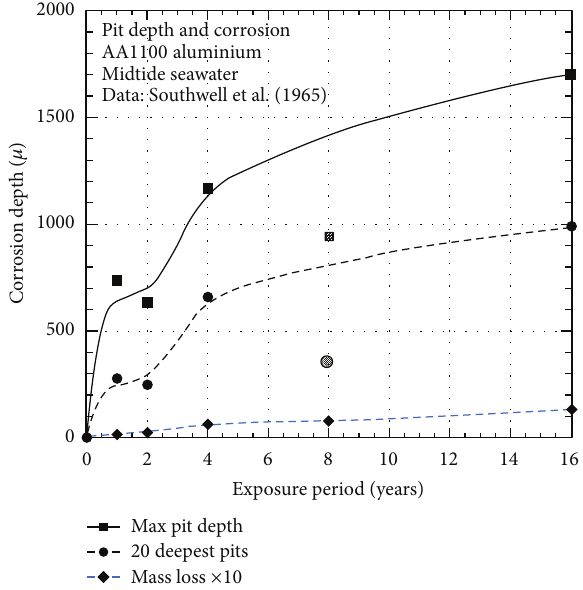
Figure 9: Data and fitted trends for AA1100 exposed to midtide marineconditions.Thechangeovertomode2occursatabout3years of exposure. Data from Southwell et al.